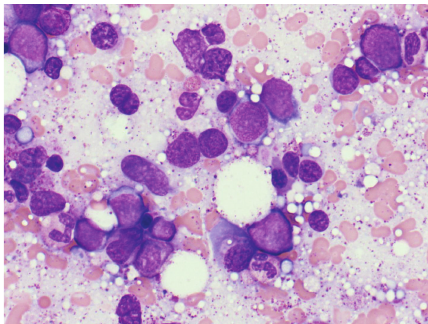
Figure 1: Bone marrow aspirate showing a hypercellular marrow with trilineage hematopoiesis and increased myeloid cell series (M:E ratio 4: 1) with eosinophilia and plasmacytosis (approxi- mately 15 to 20%).